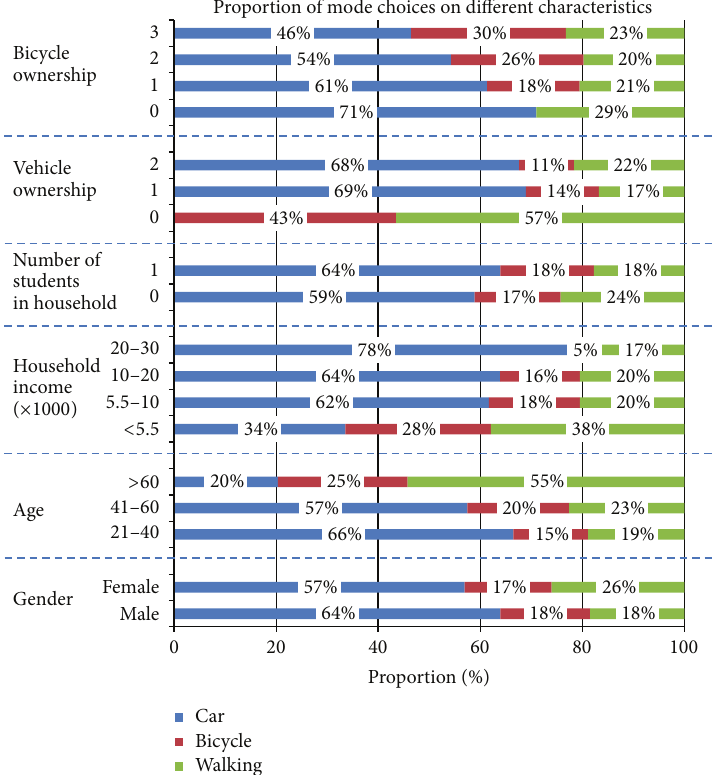
Figure 3: Proportion of mode choices in short distance